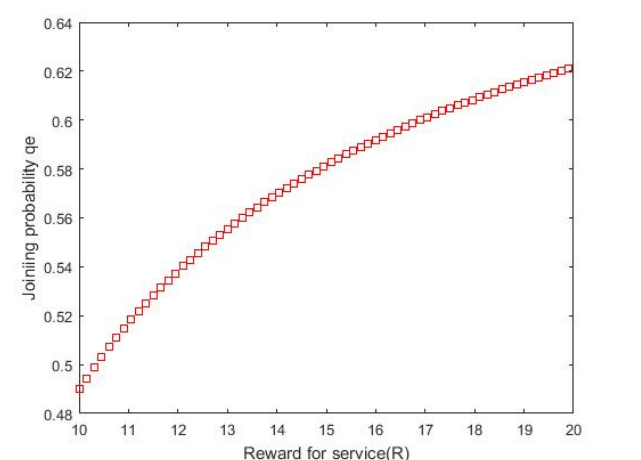
Figure 8. Equilibrium-joining probabilities vs. θ when α = 0.2, β = 0.5, λ = 0.4, µ = 1, η = 0.5, C = 1, R = 15.